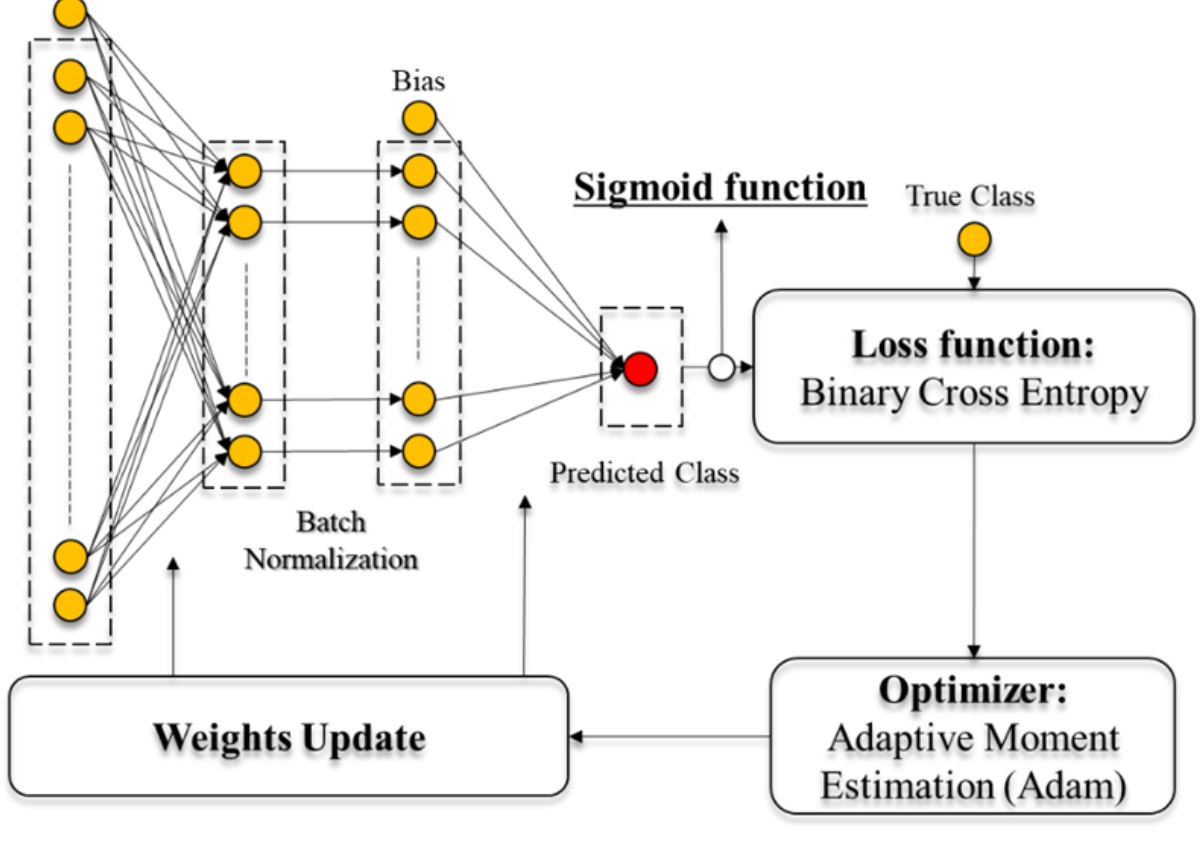
Figure 1. Architecture of a text-based artificial neural network